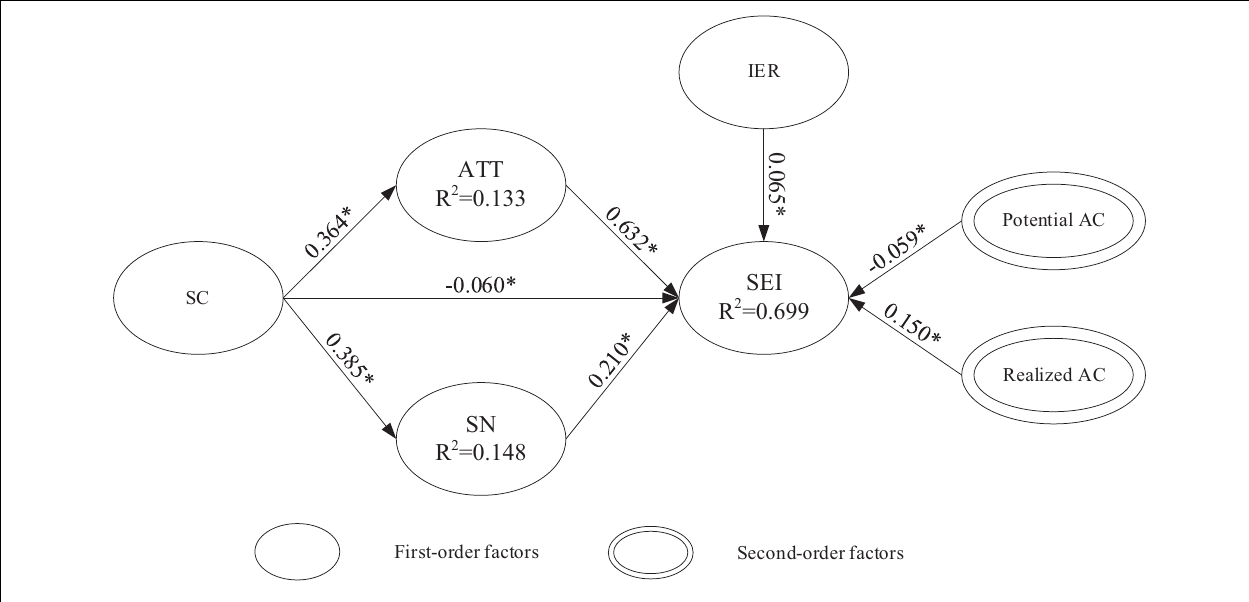
FIGURE 2 | Empirical results of the structural path model. Value on path: standardized coefficients ( β ), R 2 , Coefficient of determination and ∗ p < 0.05.